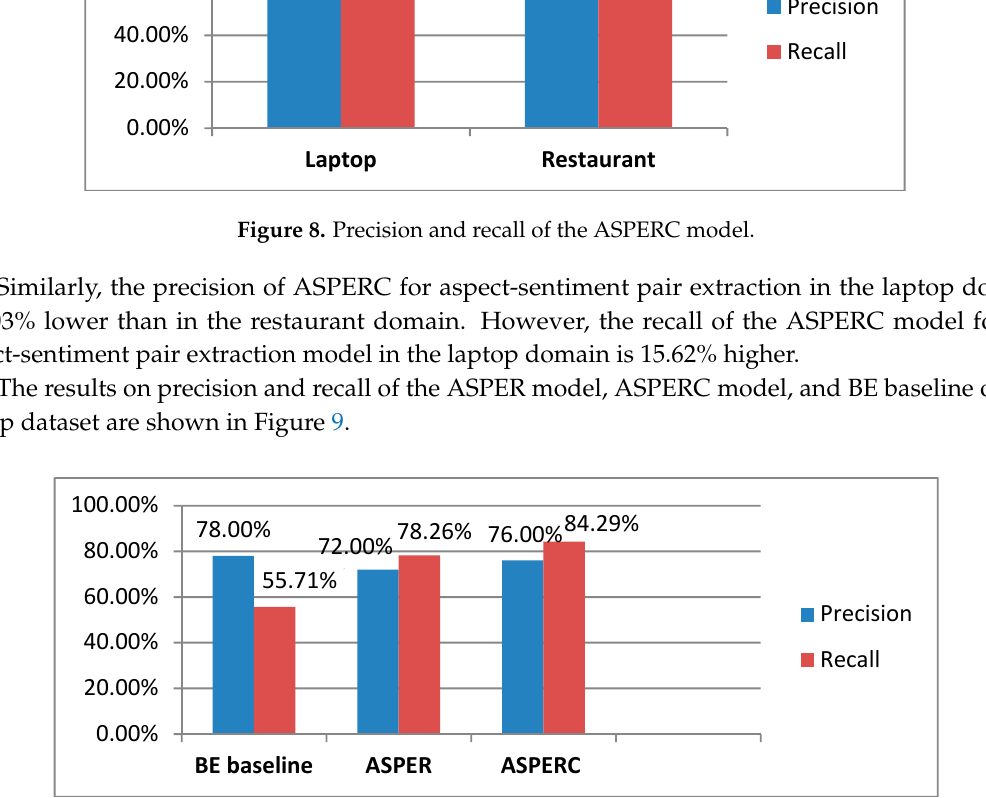
Figure 10. Precision and recall of the ASPER model, ASPERC model, and BE baseline in the restaurant dataset. The precision of ASPER is less by 1.03%, but the recall is the same with ASPERC. The precision of ASPER and ASPERC is slightly lower than the BE baseline. However, both models have higher recall compared to the BE baseline. Even tough precision of ASPER is 2.12% lower than the BE baseline, yet ASPER still managed to increase by 11.2% in terms of recall. In a similar manner, there is a little drop of precision by 1.09% in ASPERC, but still, it advances the BE baseline in recall by 11.2%. 5.4. Result Analysis In this section, the results obtained are analyzed. The two main evaluations conducted are discussed in detail. 5.4.1. Optimized Number of Review Sentences to Train the Aspect-sentiment Pair Extraction Model Determining the number of training sentences helps to set the number of testing sentences. Based on the stopping criterion, the amount of training sentences is set as 250 sentences. Following the proportion of 80:20, the amount of testing sentences is set to 63 corresponding to 250 training sentences. By using 63 testing sentences, the precision and recall of aspect-sentiment pairs extracted in the laptop domain and restaurant domain are obtained. It is observed that 63 testing sentences can provide a precision of 72.00 (ASPER)% and 76.00 (ASPERC) for the domain. Similarly, a precision of 76.00% (ASPER) and 77.03% (ASPERC) is obtained for the restaurant domain. Meanwhile, a recall of 78.26% (ASPER) and 84.29% (ASPERC) in the laptop